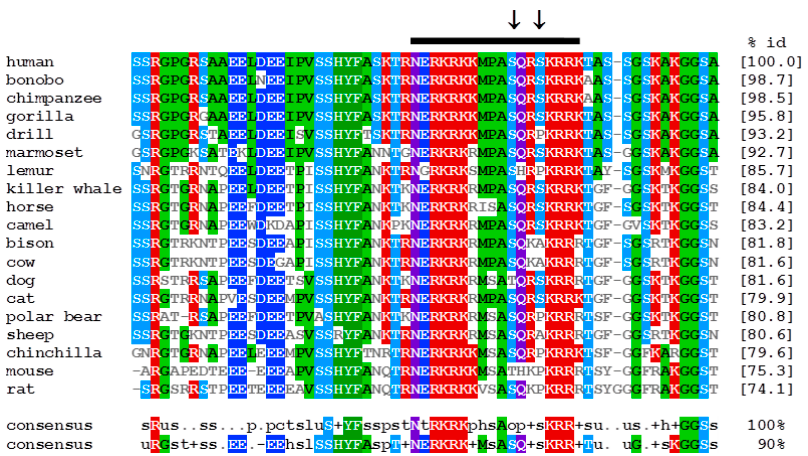
Figure 3. The TOP1-interaction domain of BLM is highly conserved in mammals. BLM protein sequences were extracted from Ensembl and aligned using ClustalW 1.83 at the European Bioinformatics Institute. The output was re-formatted in MView, using default parameters. Identities are normalized by aligned length. Residues are colored by identity and property. The TOP1-interaction region is indicated with a black bar and corresponds to human BLM residues 1332–1349. Serines 1342 and 1345 are highlighted with arrows. The nuclear localization sequence (NLS) region of BLM is contained within this region (1334–1349). The number in brackets at the end of each entry indicates percentage identity of the full-length protein sequence with respect to the human BLM protein.